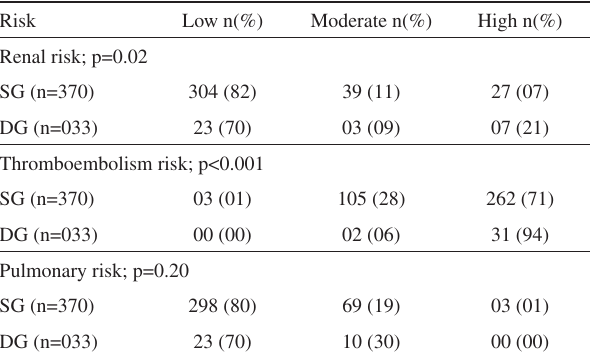
Table 6 – Evolution related to the renal, thromboembolism and pulmonary risk